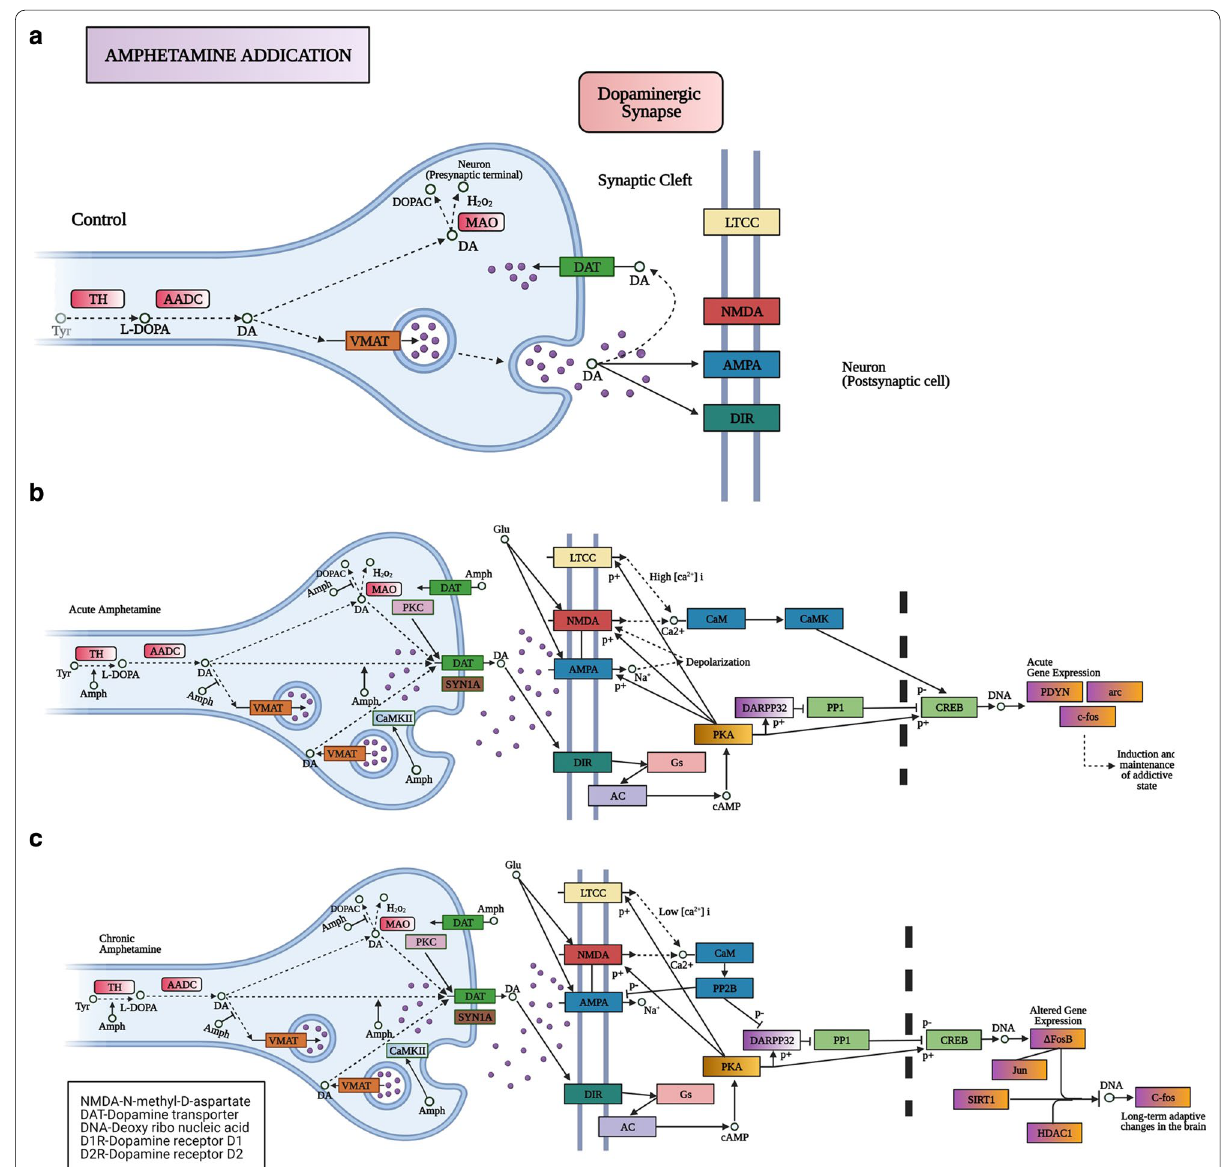
Fig. 2 Amphetamine and its related signalling pathway: Positive ions (Ca 2 + and Na + ) can pass through the membrane when these receptors are activated. Released DA binds to the D1R receptor at the same time. Depolarization occurs as a result of positive ion flux, resulting in an increase in Ca 2 + concentration. When activated D1R binds to Gs, it causes adenyl cyclase, an enzyme that converts ATP to cAMP, to become activated, which activates the PKA signalling pathway. The cAMP binds to the CREB protein, which regulates gene expression and thereby induces the expression of PDYN, arc and c-fos genes, which are responsible for the induction and maintenance of